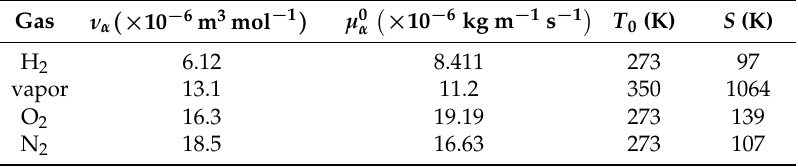
Table 1. Gas composition and parameters for viscosity calculations by Sutherland’s